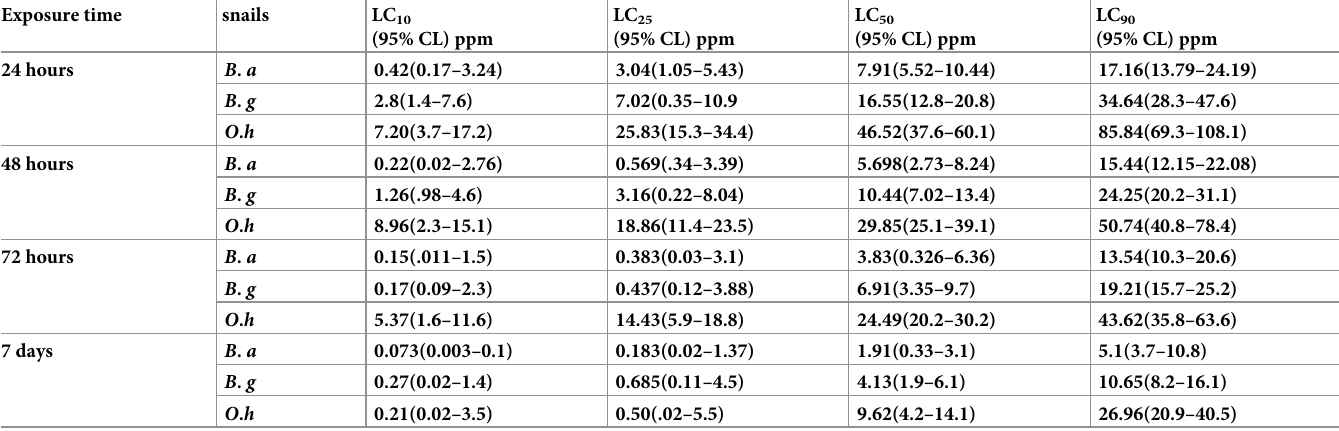
Table 1. Molluscicidal efficacy of the silver nanoparticles (Ag-NPs) against snail species. Exposure time